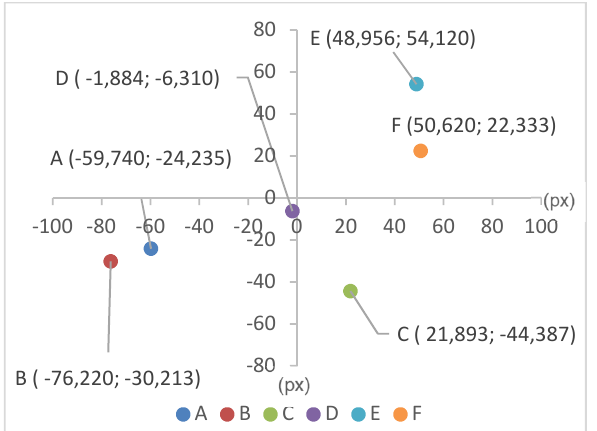
Figure 8. Estimated principal point coordinates of the six cameras mounted on the rig and processed after the Exif